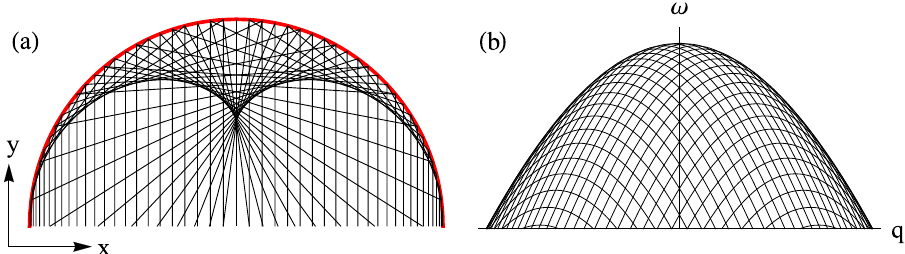
Fig. 4 Alternative understanding of Van Hove singularities as caustic features in the collective spin dynamics. a Caustic features in ray optics. Parallel light rays (black lines) enter an optical system at different positions. When these light rays re fl ecting from a circular mirror (red line) coalesce, they give rise to caustic features in real space. b Caustic features in a spin response. The two-magnon continuum can be understood as a sum of sharp contributions, ω = ε + ε fi xed momentum k of the fi rst magnon. When these sharp contributions (black lines) coalesce, they give rise to k q − k , each corresponding to a caustic features in the two-magnon continuum. Note that the spin response shown here is for a one-dimensional model system; for the two-dimensional system in consideration, the caustic features appear inside the continuum (not at its edge) and are weaker as they correspond to logarithmic (rather than square-root) singularities.